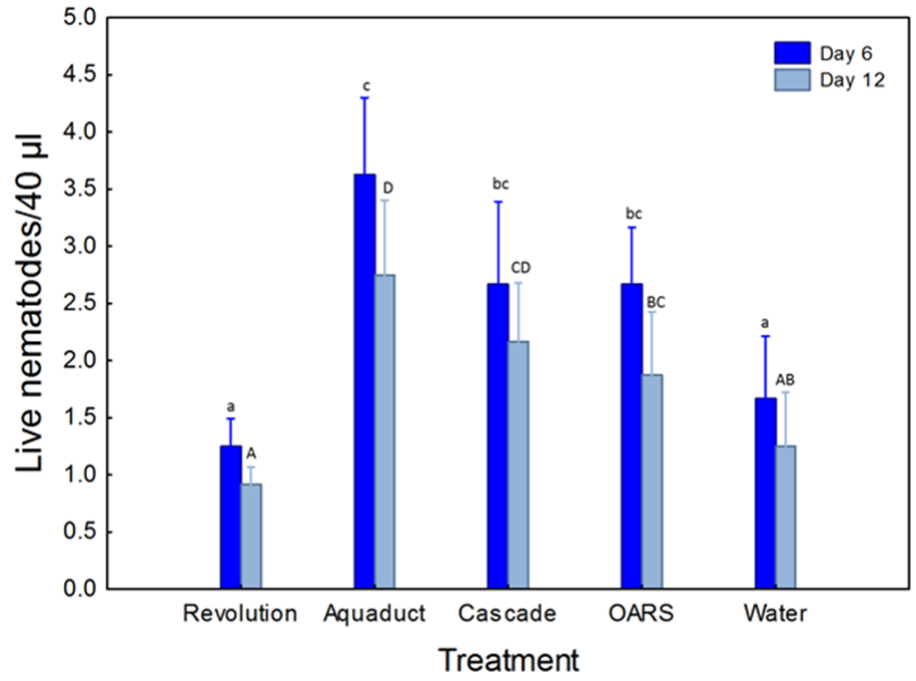
Figure 1. Mean (±SE) number of live infective juvenile Heterorhabditis bacteriophora Poinar per 40 µL sample taken from Petri dishes containing one of four different surfactant solutions or water over the course of 12 days. Means with the same letter are not significantly different at  = 0.05. Comparisons at 6 days described by lower-case letters and comparisons at 12 days described by upper-case